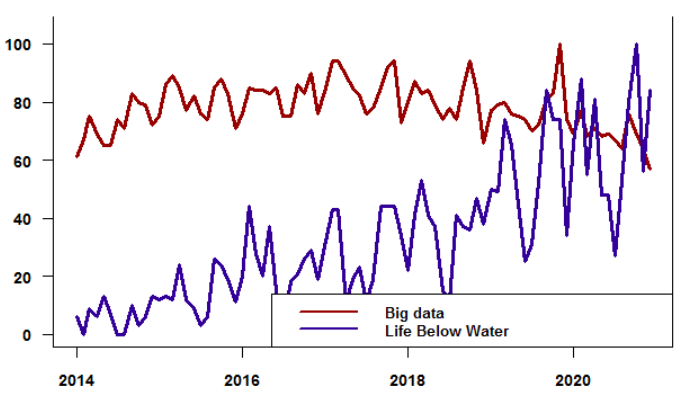
Figure 15. Big Data and SDG 14 global Google trends since